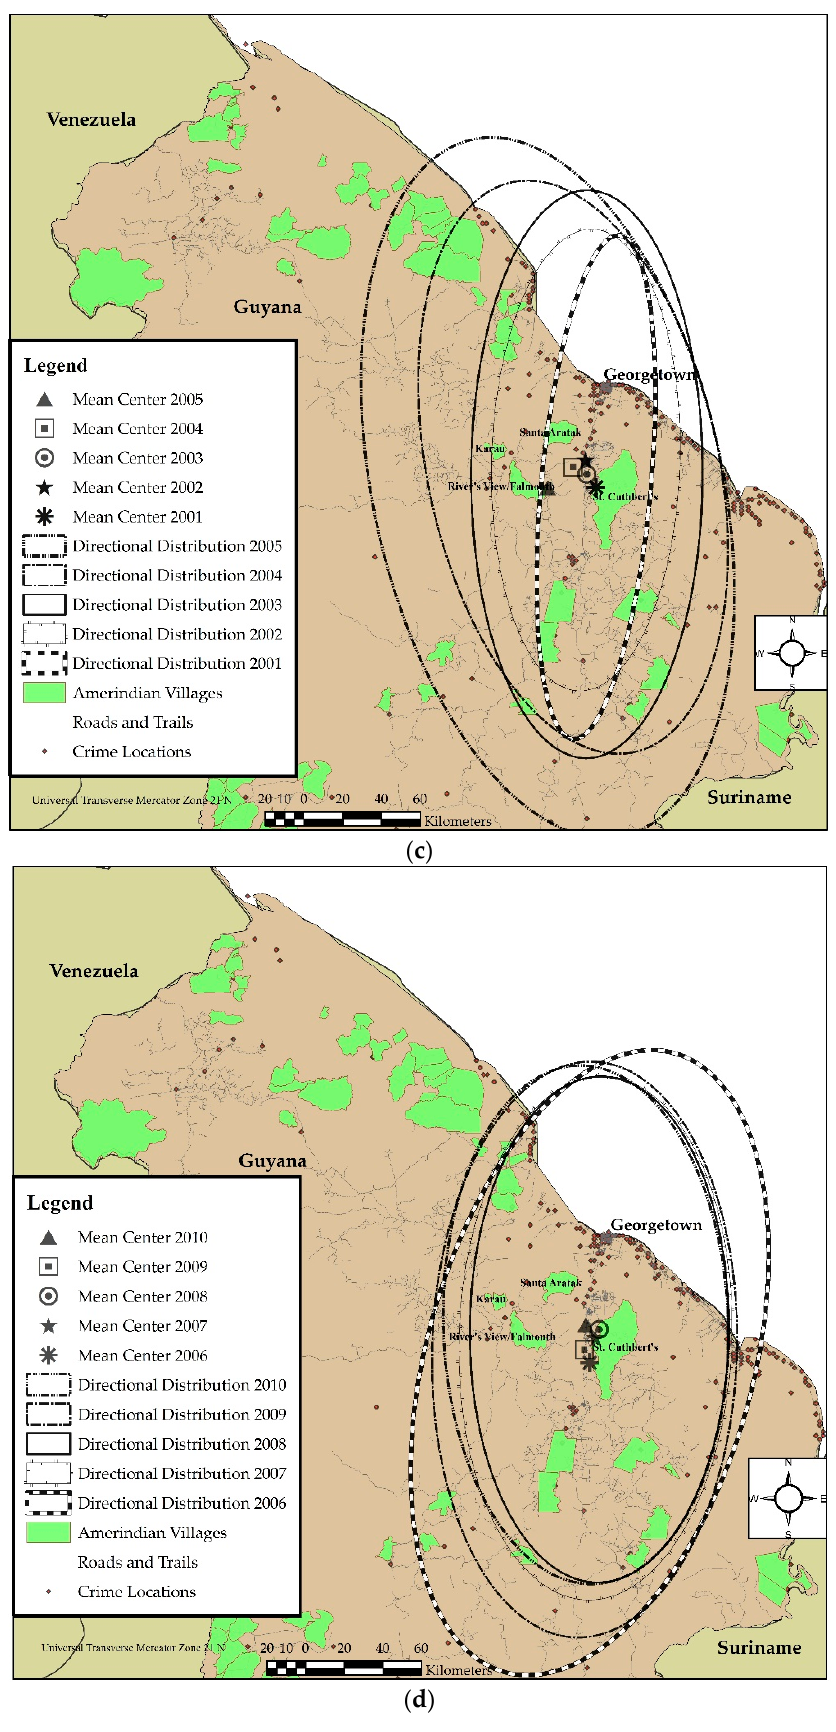
Figure 3. The distribution of mean centers and standard deviational ellipse: ( a ) (top): 1986–1995; ( b ) (second from top): 1996–2000; ( c ) (third from top): 2001–2005; and ( d ) (bottom): 2006–2010.